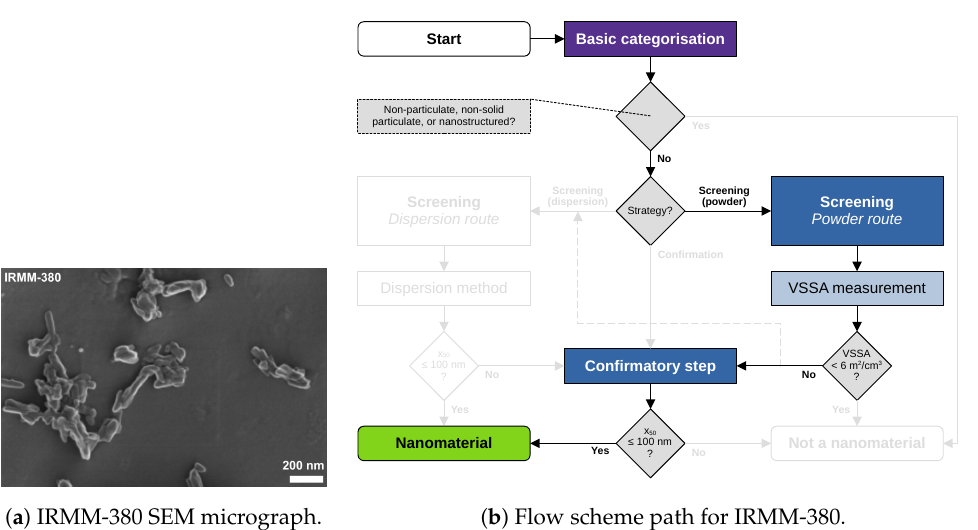
Figure 5. IRMM-380 (pigment yellow 83 nano): ( a ) representative SEM micrograph, and ( b ) respective flow scheme path. First, the tier 1 method BET yielding a VSSA = 93 m 2 /cm 3 leads to the decision to perform a confirmatory step. Then, the tier 2 method TEM yielding an x 50 = 39 nm leads to a “nanomaterial”